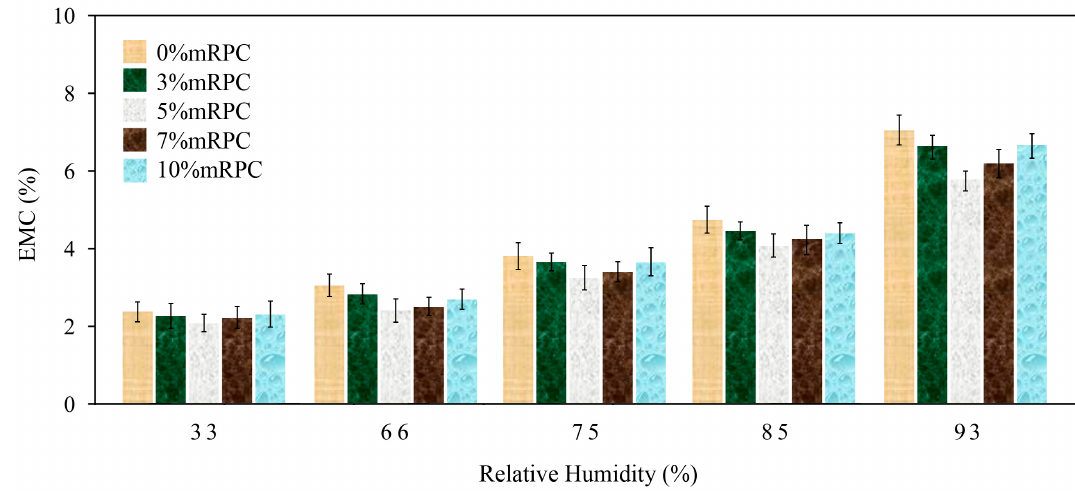
Figure 2. Comparison of the EMCs of the composites along the moisture adsorption direction.